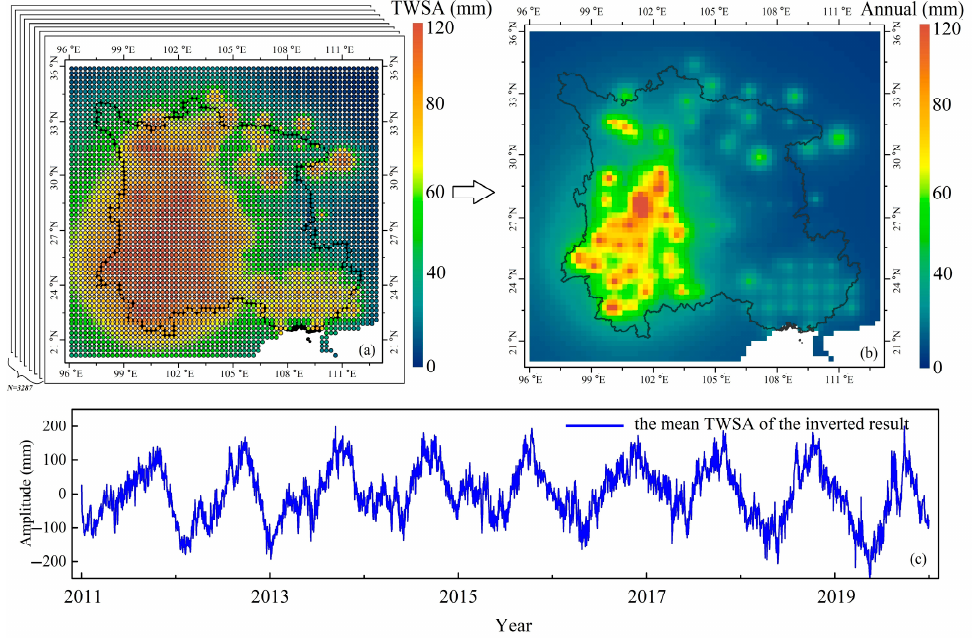
Figure 7. The derived result of the daily TWSA ( a ) and annual items ( b ). Figure 7 indicates that the TWSA in the study region can be inverted by the MLLIM.